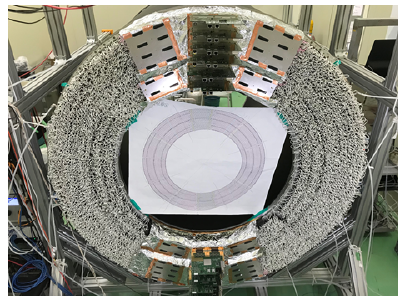
Figure 10: Layout of the COMET experi- ment in